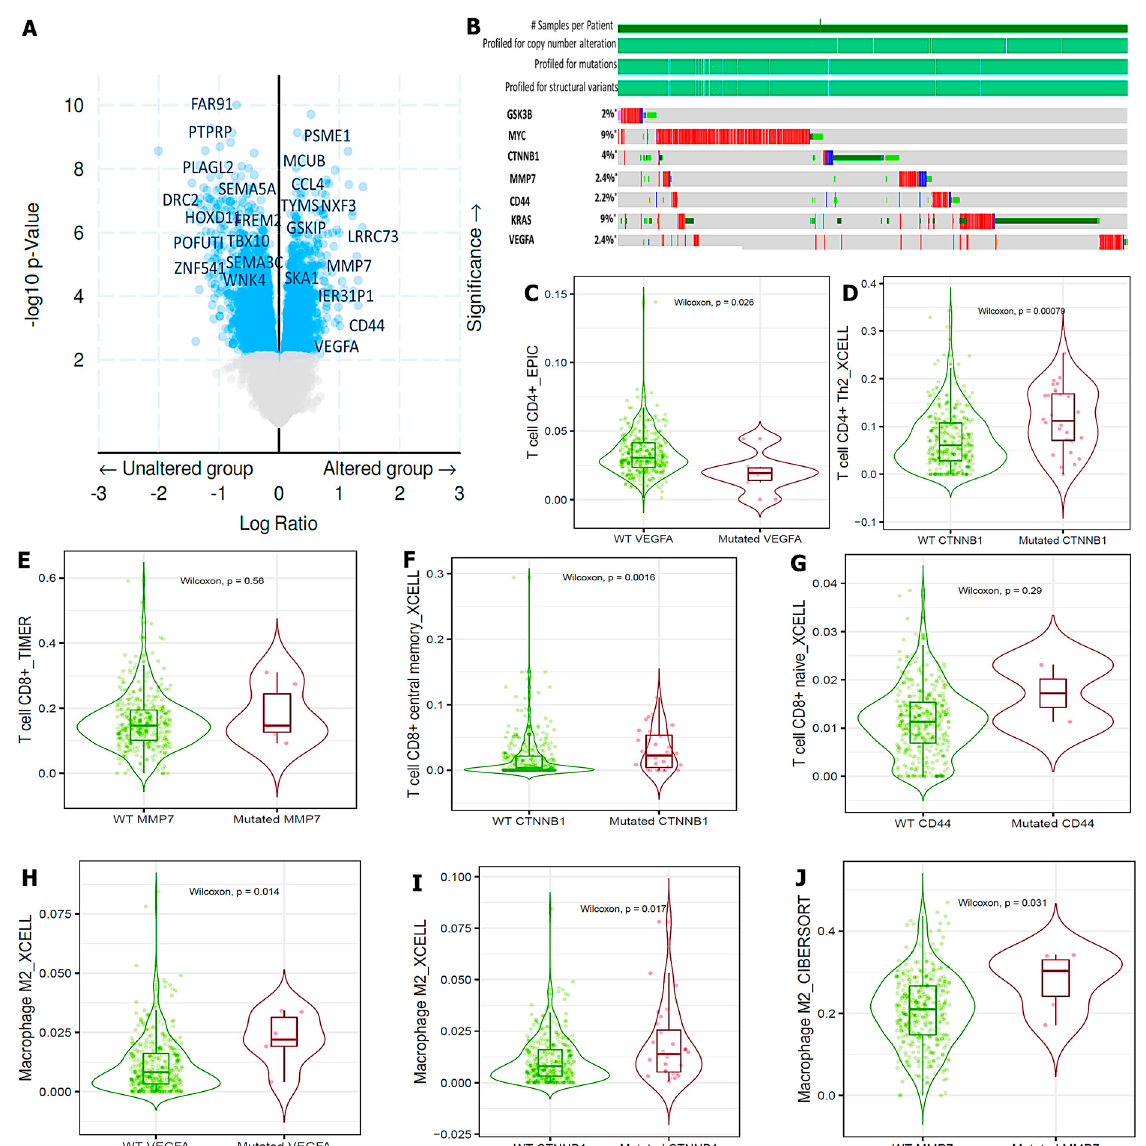
Figure 7. Vascular endothelial growth factor- α ( VEGFA )/beta catenin ( CTNNB1 )/matrix metallopro- teinase ( MMP)-7 /cluster of differentiation 44 (CD44) oncogenes were altered and amplified in colorectal cancer (CRC). ( A ) volcano plot showing upregulated genes in CRC altered and unaltered cohorts ( B ) Oncoprint analysis showed amplification (marked with *) of VEGFA/CTNNB1/MMP7/CD44 based on percentages of separate genes, with GSK3 β (2%), MYC (9%), CTNNB1 (4%), MMP7 (2.4%), CD44 (2.2%), KRAS (9%), and VEGFA (2.4%) in CRC. ( C – J ) Mutation frequency of VEGFA/CTNNB1/MMP7/CD44 Genes shown by the violin plots of immune infiltration distribution including CD4 + T-cells, CD8 + T-cells, and macrophages in the wild-type compared to mutant